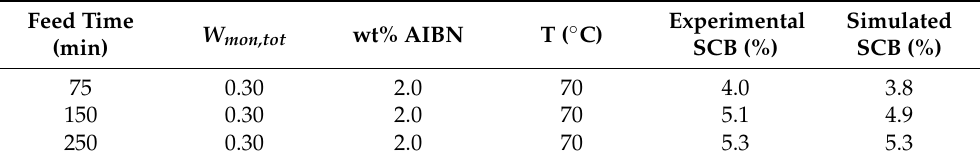
Table 2. A comparison of measured and simulated %SCB levels from starved-feed semi-batch MA homopolymerization at 70 ◦ C and α EtOH = 0.75. The reported w mon,tot and wt% AIBN are expressed relative to the total recipe after feeding, with the reported %SCB values for samples extracted from the reactor at the end of the feed period.